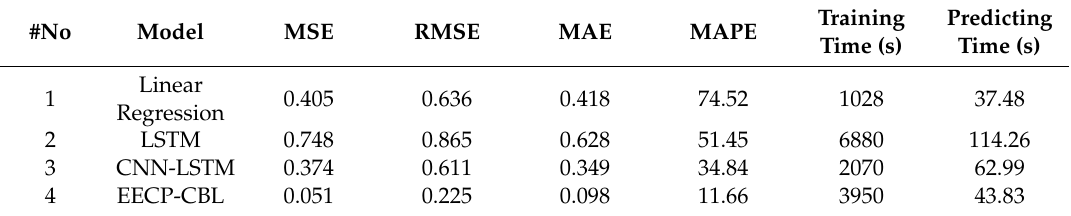
Table 3. Performances of the experimental methods for minutely